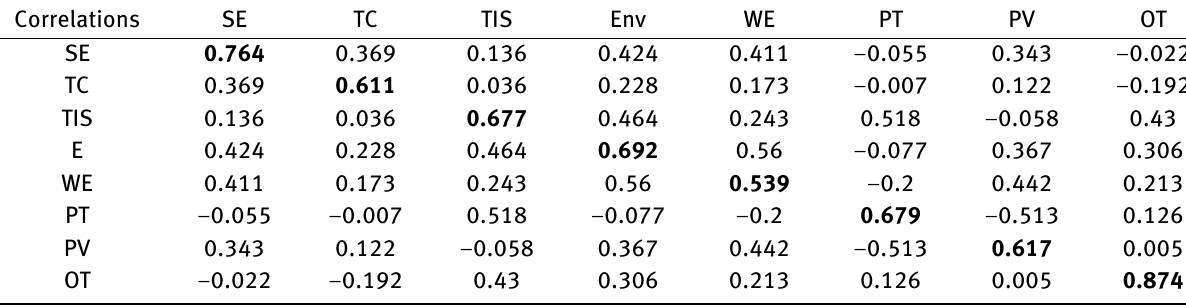
Table 4: Correlations among latent variables with square roots of AVEs Correlations